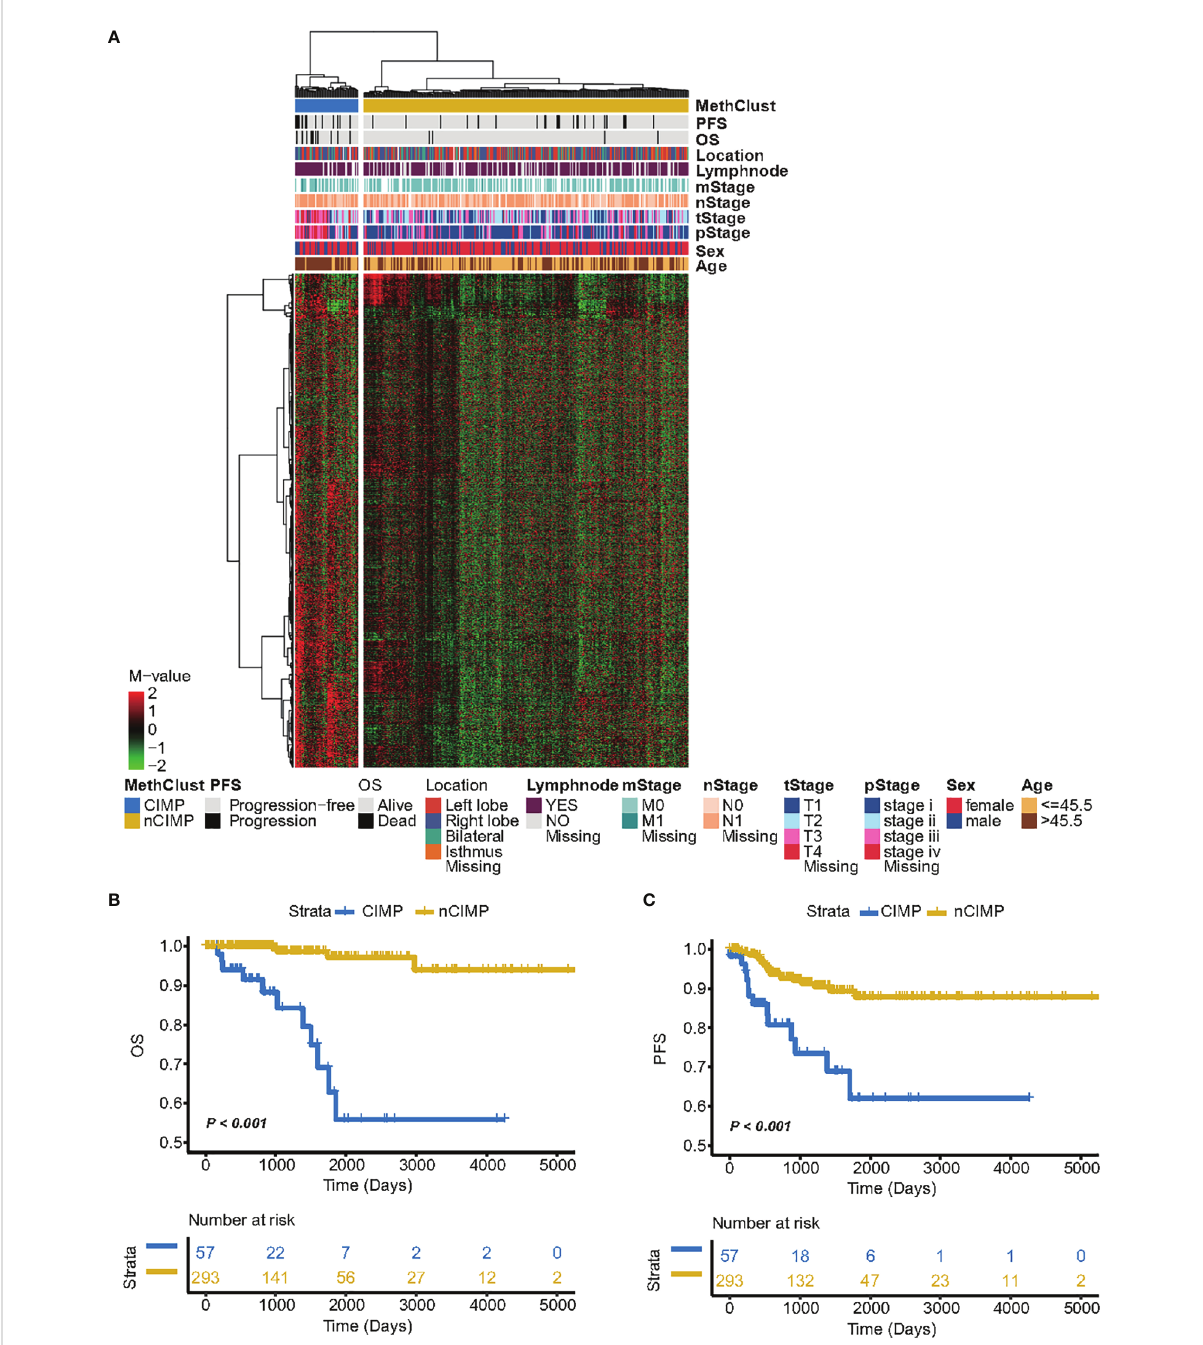
FIGURE 1 Identi fi cation of CIMP and its association with clinical outcome. (A) Heatmap showing the DNA methylation pattern between CIMP (high- methylation) and nCIMP(low-methylation) using DNA methylation M-values. Kaplan-Meier curves between two epigenetic phenotypes regarding (B) OS (Overall survival) and (C) PFS (Progression free